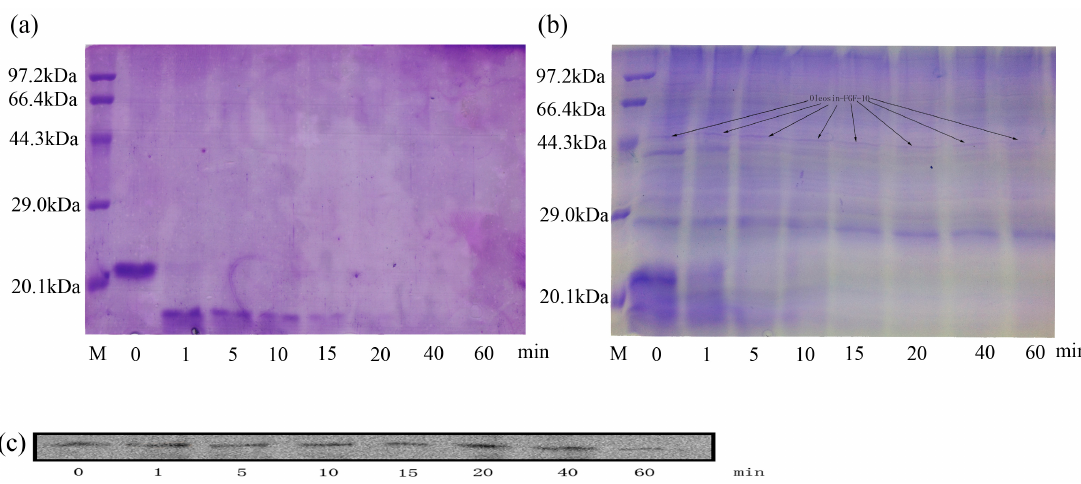
Figure 11. Sodium dodecyl sulfate polyacrylamide gel electrophoresis (SDS-PAGE) and western blot to analyze the proteolysis. ( a ) The method of SDS-PAGE to analyze the rhFGF-10; ( b , c ) the oleosin- rhFGF-10 was detected by SDS-PAGE and western blot to confirm the stability of interest protein.